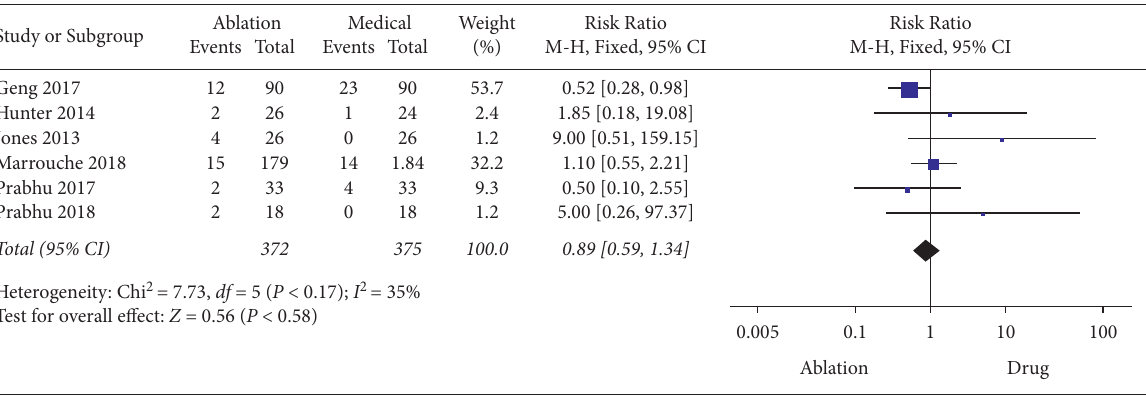
Figure 8: Forest plot of CA versus medical therapy: complications.